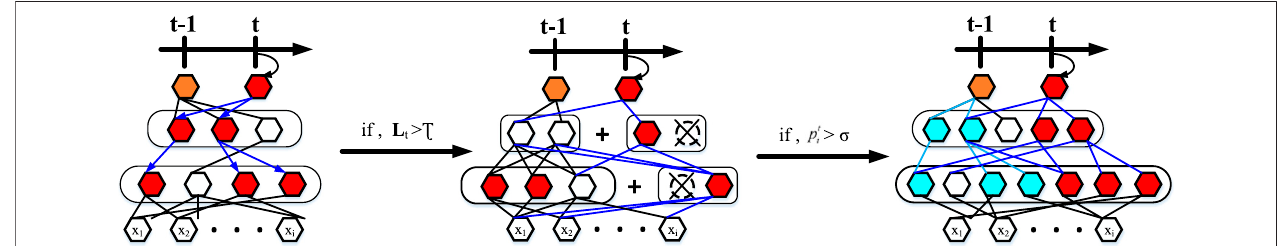
FIGURE 5 | Incremental learning for dynamically scalable networks.